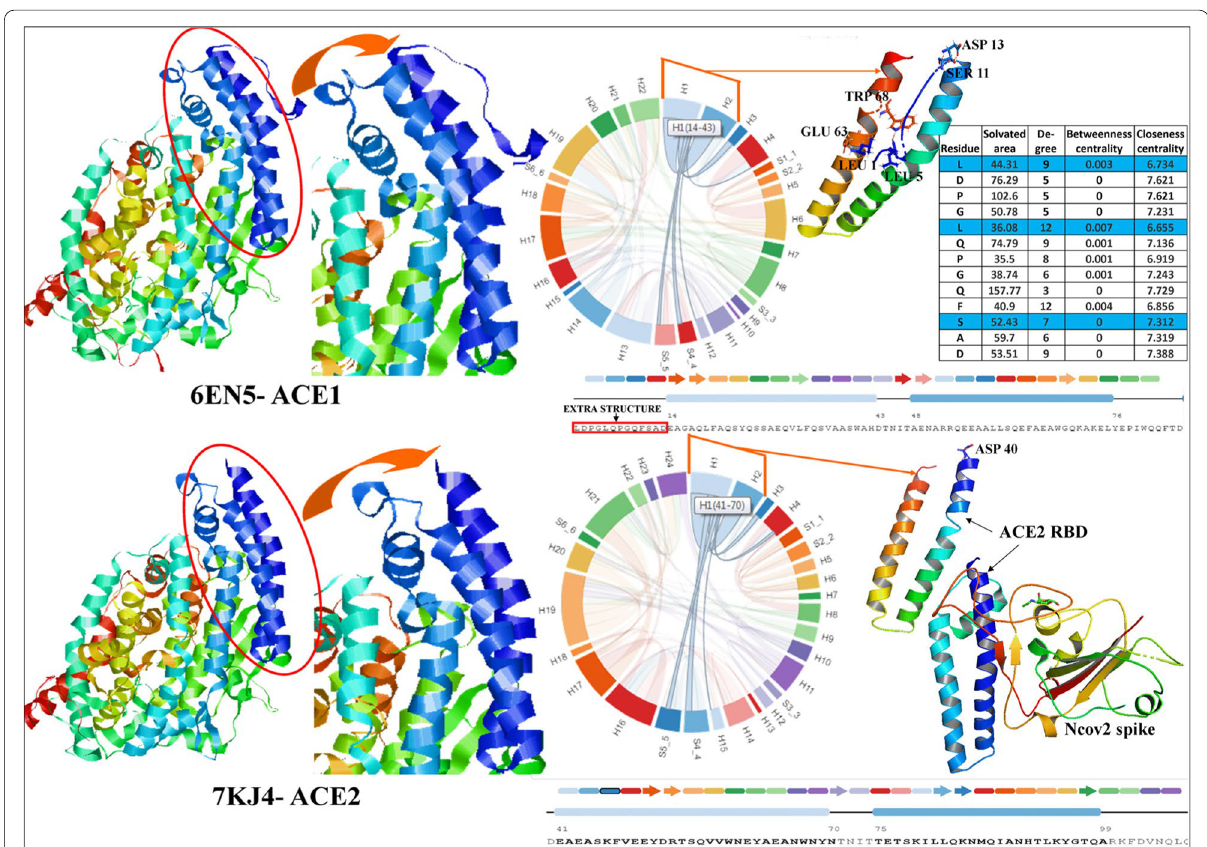
Fig. 5 Comparative study between ACE1 and ACE2 receptor binding domain (RBD). Though they have sequence, secondary and tertiary structure level similarity, ACE1 have extra appendage which interacted with the RBD domain with amino acids combination of LEU1-GLU63, LEU5- TRP68 and SER11- ASP13, which blocks the nCOV spike attachment with ACE1. Whereas, ACE2 has no extra part which facilitated the nCOV2 spike